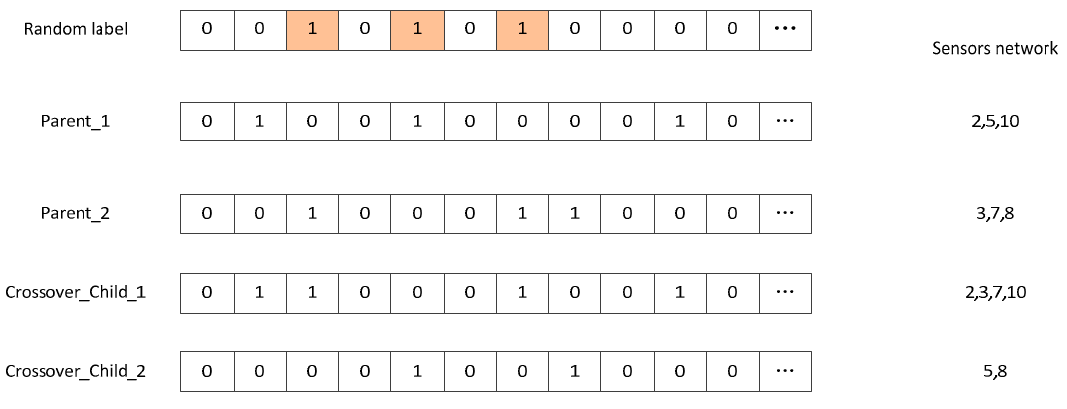
Figure 4. Operation of crossover.